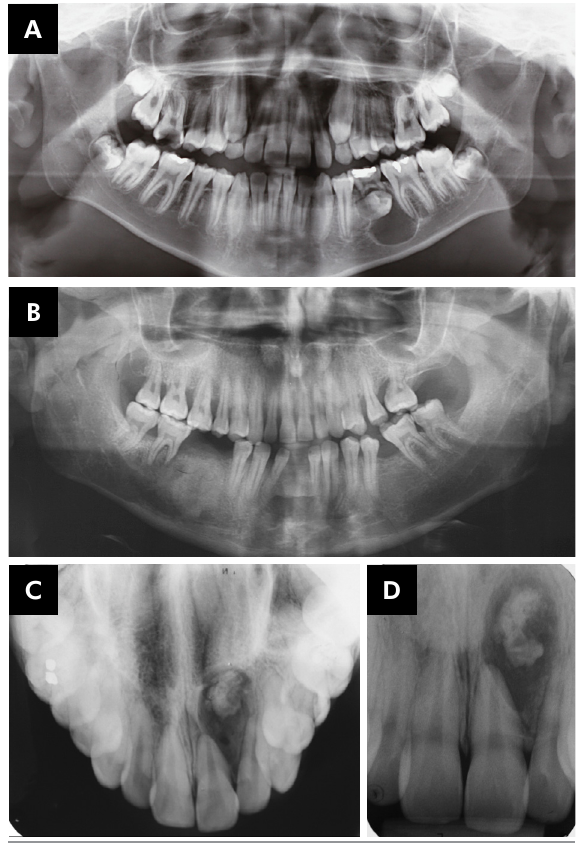
Figure 1. (A) Panoramic x-ray showing a radiolucent lesion involving the crown of the tooth 35 (Dentigerous cyst). (B) Poor delimited radiopaque lesion in right mandible (osteosarcoma). (C,D) An occlusal and periapical x-ray showing a mist lesion involving the anterior region of the maxilla (calcifying cystic odontogenic